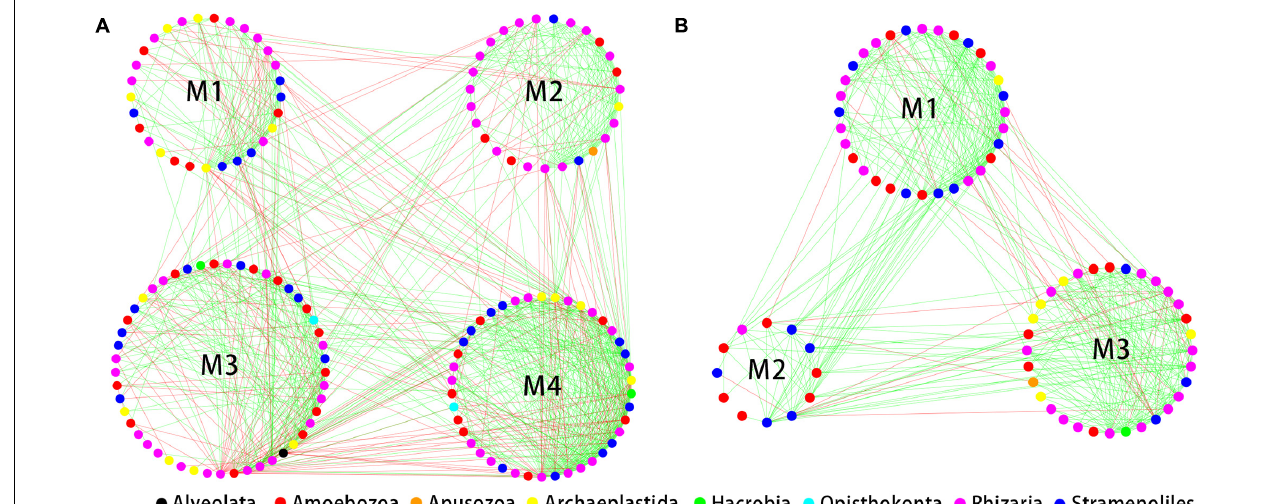
FIGURE 5 | Correlation-based network analysis showing all potential interactions between protist operational taxonomic units (OTUs) in the bulk soil ( A , n = 18) and rhizosphere ( B , n = 54) of soybean fields in China. Node colors indicate different protist taxonomic groups. Lines connecting nodes (edges) represent positive (red) or negative (blue) co-occurrence